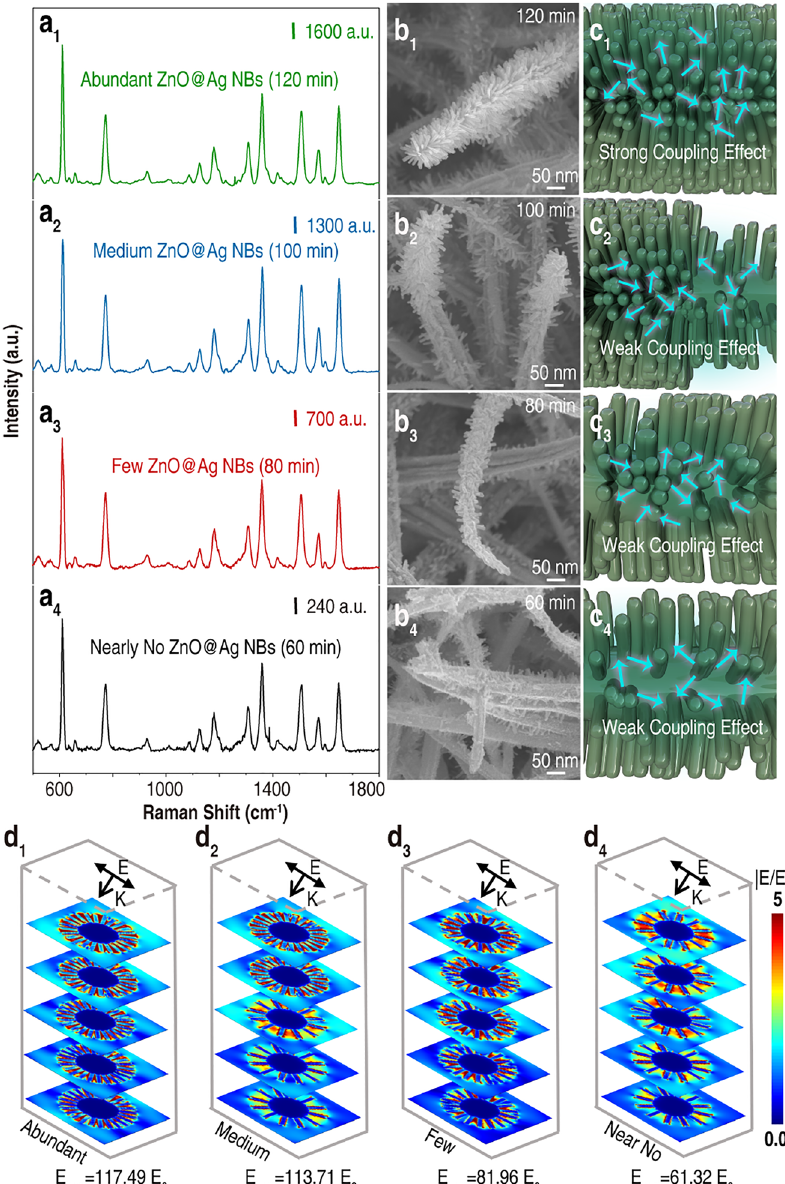
Figure 3: (a 1 – a 4 ) Raman spectra of R6G collected from CuO@ZnO@Ag NSs with different ZnO NB density; (b 1 – b 4 ) SEM imagesofCuO@ZnONSswith differentZnO NB density; (c 1 – c 4 ) schematic of the in fl uence by ZnO NBs; and (d 1 – d 4 ) simulated EFDs in CuO@ZnO@Ag NS with different ZnO NB